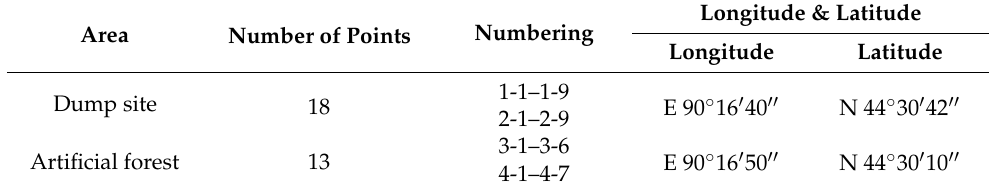
Table 1. Number and location of sampling points.